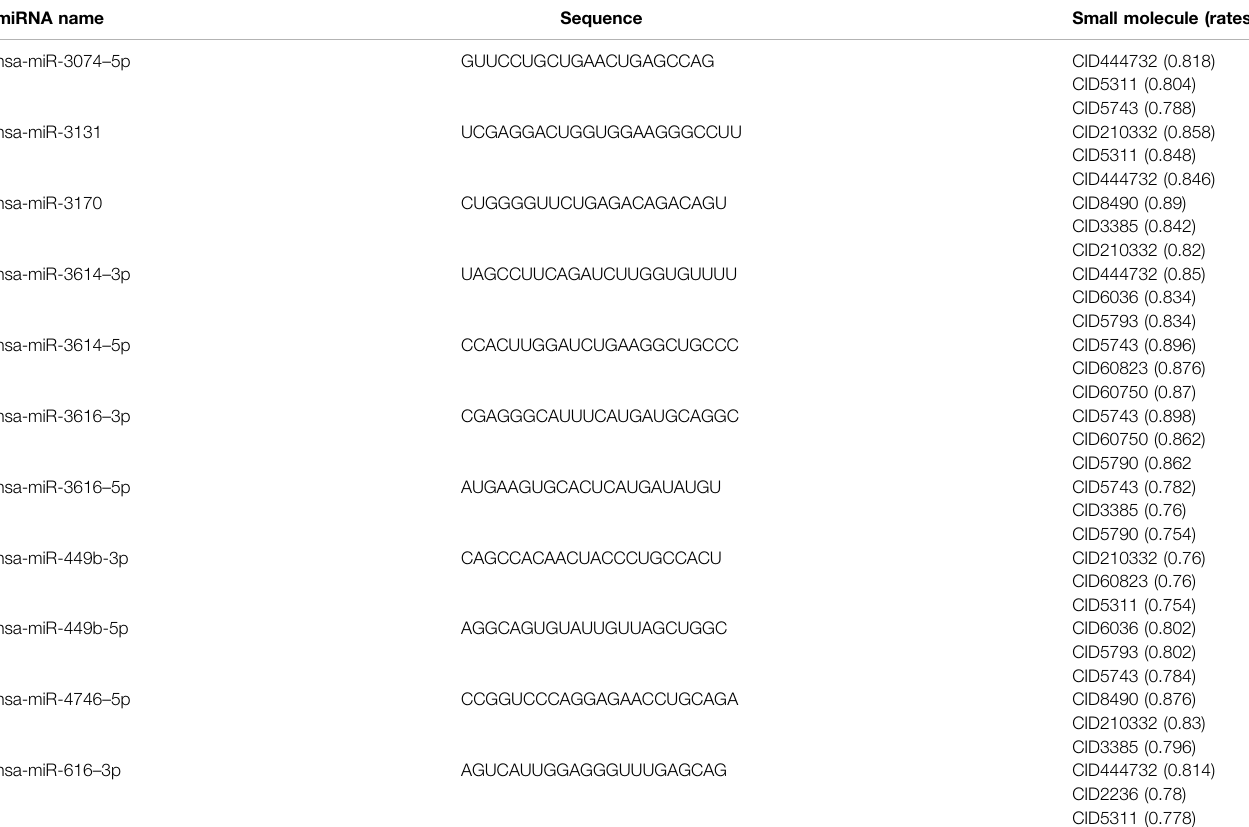
TABLE 4 | Top 3 small molecules are predicted to regulate their oncogenic